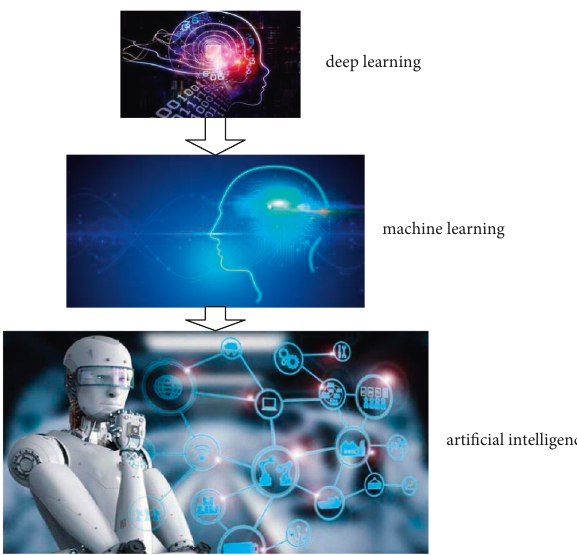
Figure 3: Artificial intelligence, machine learning, and deep